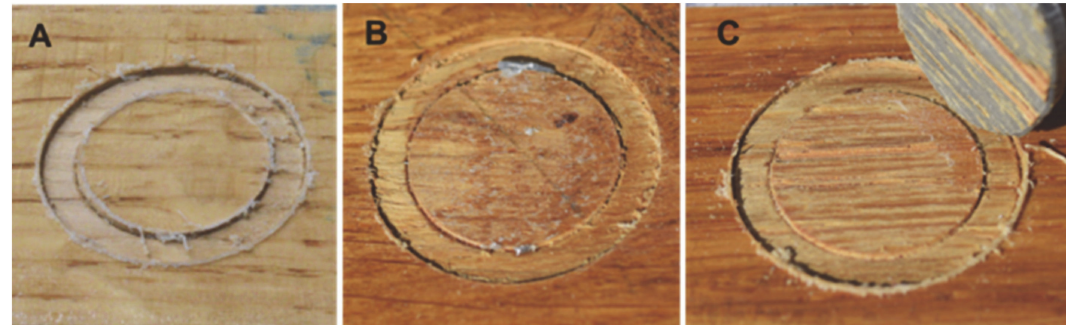
Figure 6. Failure locus after pull-off tests on solid oak wood: ( A ) adhesive failure mode on the untreated PLA/epoxy adhesive interface, ( B ) adhesive failure mode on the treated PLA/wood interface, and ( C ) mixed adhesive/cohesive failure mode on the treated PLA/wood